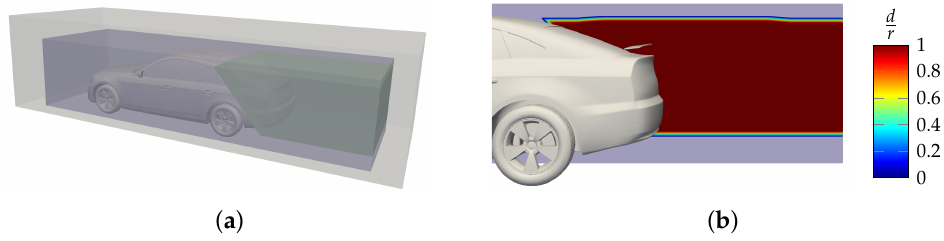
Figure 12. oPOD domain decomposition and signed differences for the DrivAer use case. ( a ) oPOD domain decomposition. ( b ) Signed distance field slice of the foreground